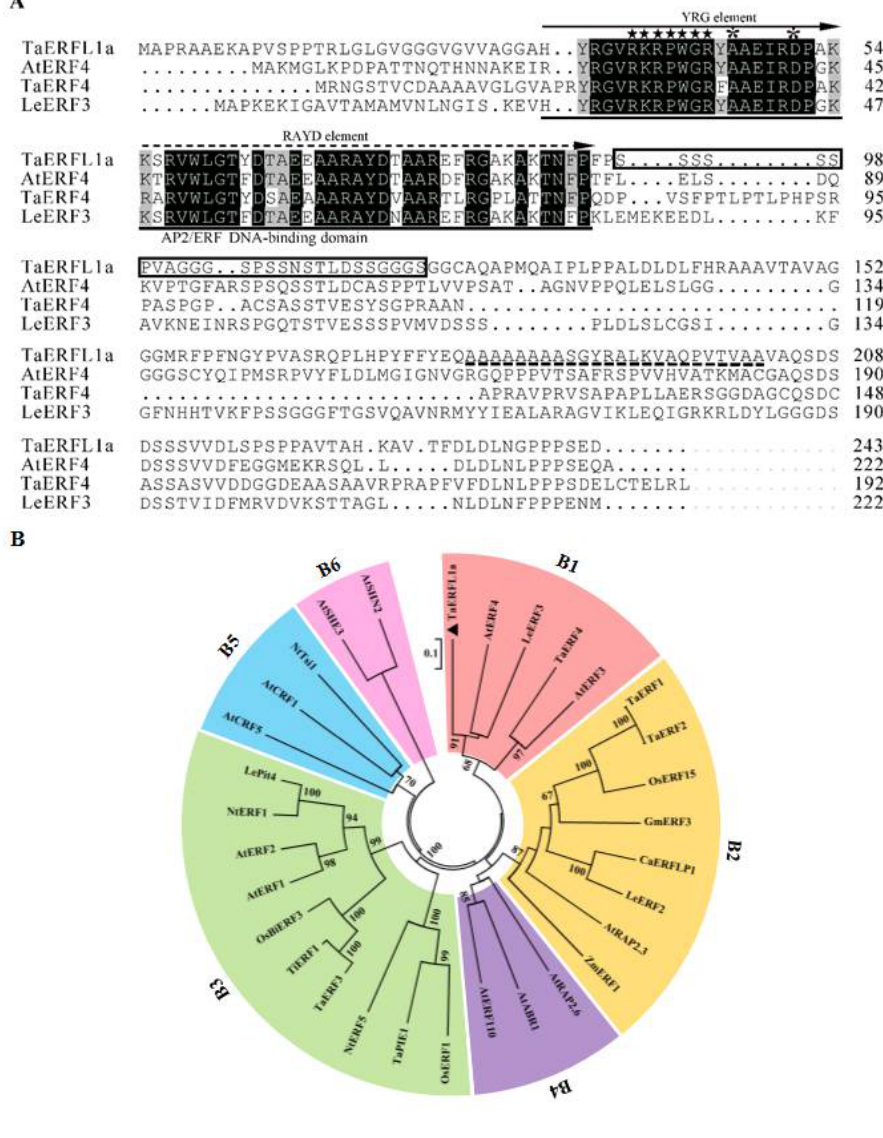
Figure 1. Multiple alignment ( A ); and phylogenetic tree ( B ) of TaERFL1a. Multiple alignment of TaERFL1a with AtERF4 (AY140030), TaERF4 (JX014257), and LeERF3 (AY192369). Boxes in black and gray shades represent 100.0% and 75.0% similarities of ERF proteins in B1 subgroup, respectively. AP2/ERF DNA binding domain is indicated with single line, and it contains conserved YRG (YRGVRKRPWGRYAAEIRDPAK) and RAYD (KSRVWLGTYDTAEEAARAYDTAAREFRGAK AKTNFP) elements and they are indicated with solid and dotted arrows, respectively. The nuclear localization signal sites are shown in